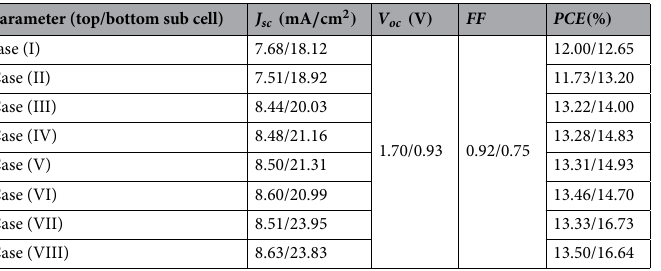
Table 1. The output electrical parameters of the top and bottom sub cells for all proposed